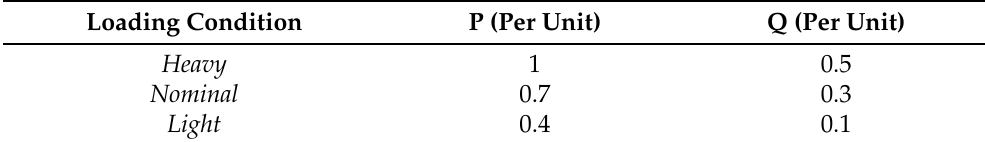
Table 2. Different loading